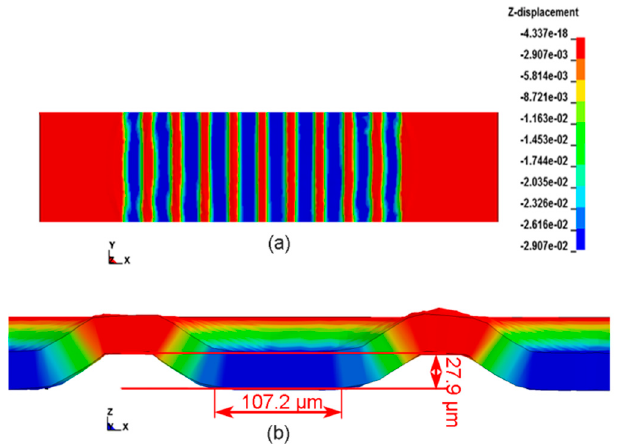
Figure 11. Image of the formed part under the laser energy of 1800 mJ in the numerical simulation: ( a ) surface morphology of the whole formed workpiece and ( b ) cross-section morphology of one microchannel.